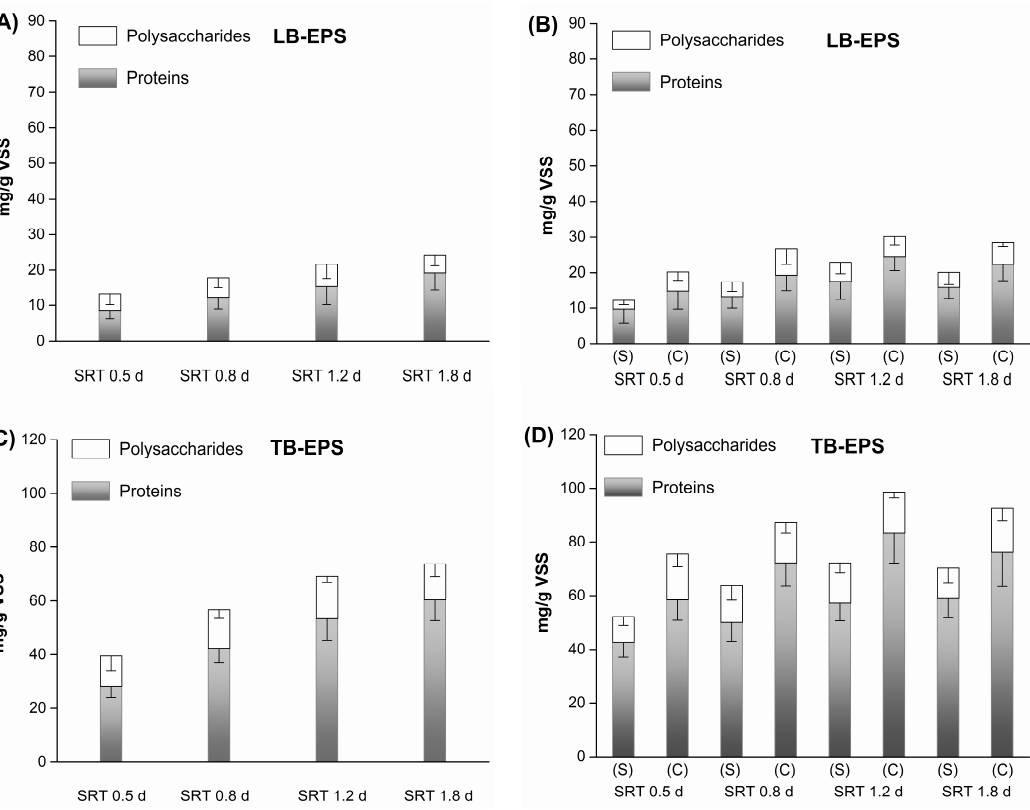
Figure 4. Specific proteins and polysaccharides concentrations of the (top) loosely bound (LB) and (bottom) tightly bound (TB) extracellular polymeric substances (EPS) fractions at different SRTs for ( A , C ) HL-MBR and ( B , D ) HRCS-MBR. Error bars show standard errors.